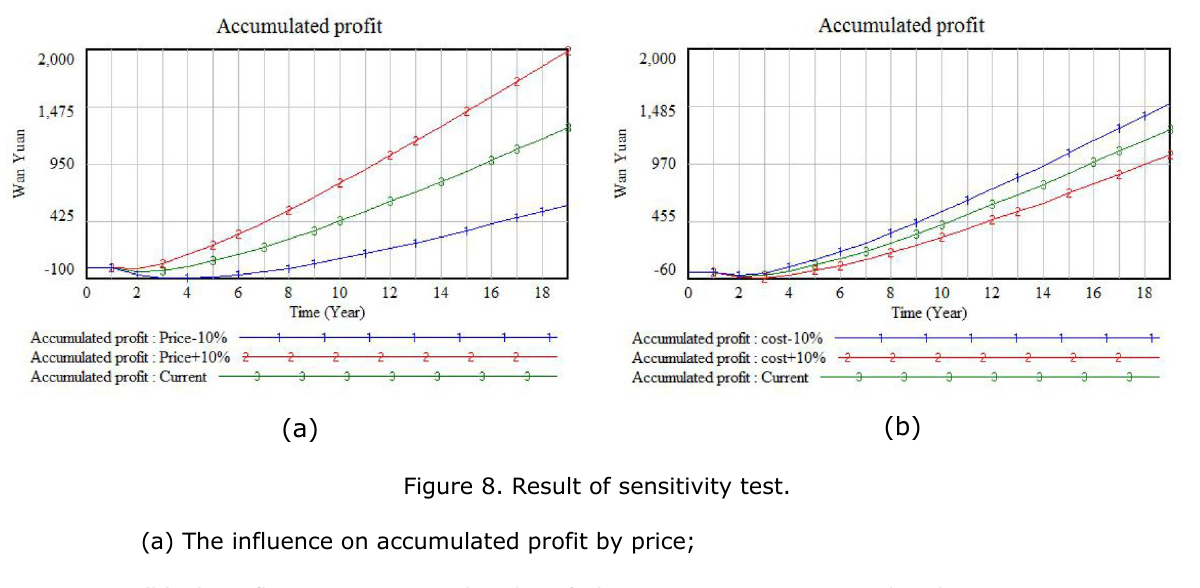
Figure 8. Result of sensitivity test.